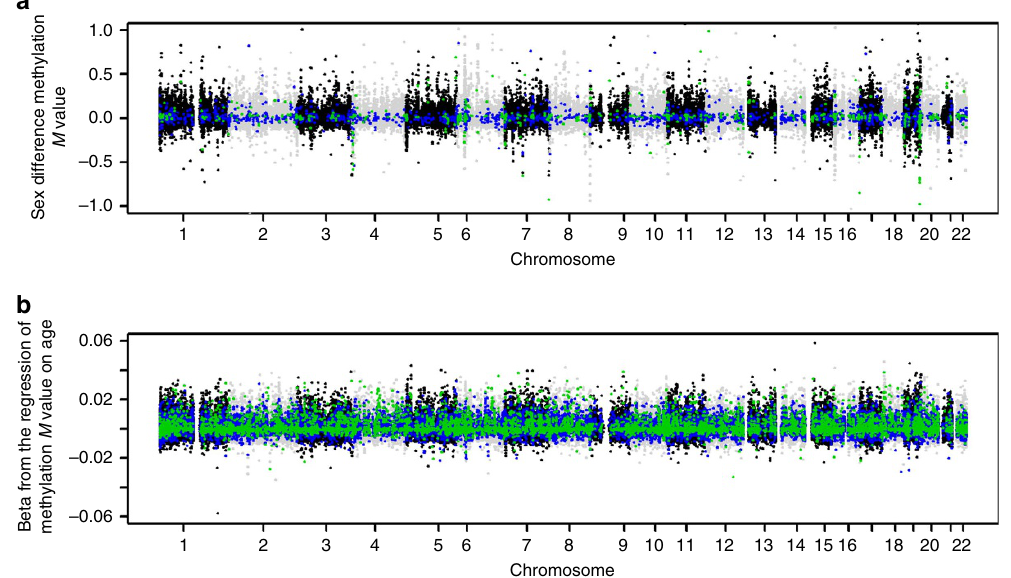
Figure 4 | Main effects of age and sex and their interaction with genetic and environmental effects. ( a ) Main and interaction effects of sex. The x axis denotes chromosomal position. The y axis denotes the b -value from the regression of methylation M value on sex (while correcting for age, white blood cell counts and technical covariates). Sites where the genetic variance showed significant sex interaction are indicated in blue. Sites where the environmental variance showed significant sex interaction are shown in green. The y axis is truncated at (cid:3) 1 and 1 to improve visibility, excluding a small number of sites with regression b -values up to (cid:3) 2.4 and 2.6. ( b ) Mean and interaction effects of age. The x axis denotes chromosomal position. The y axis denotes the b -value from the regression of methylation M value on age (while correcting for sex, white blood cell counts and technical covariates). Sites where the genetic variance showed significant age interaction are indicated in blue. Sites where the environmental variance showed significant age interaction are shown in green. Results are based on data from 2,603